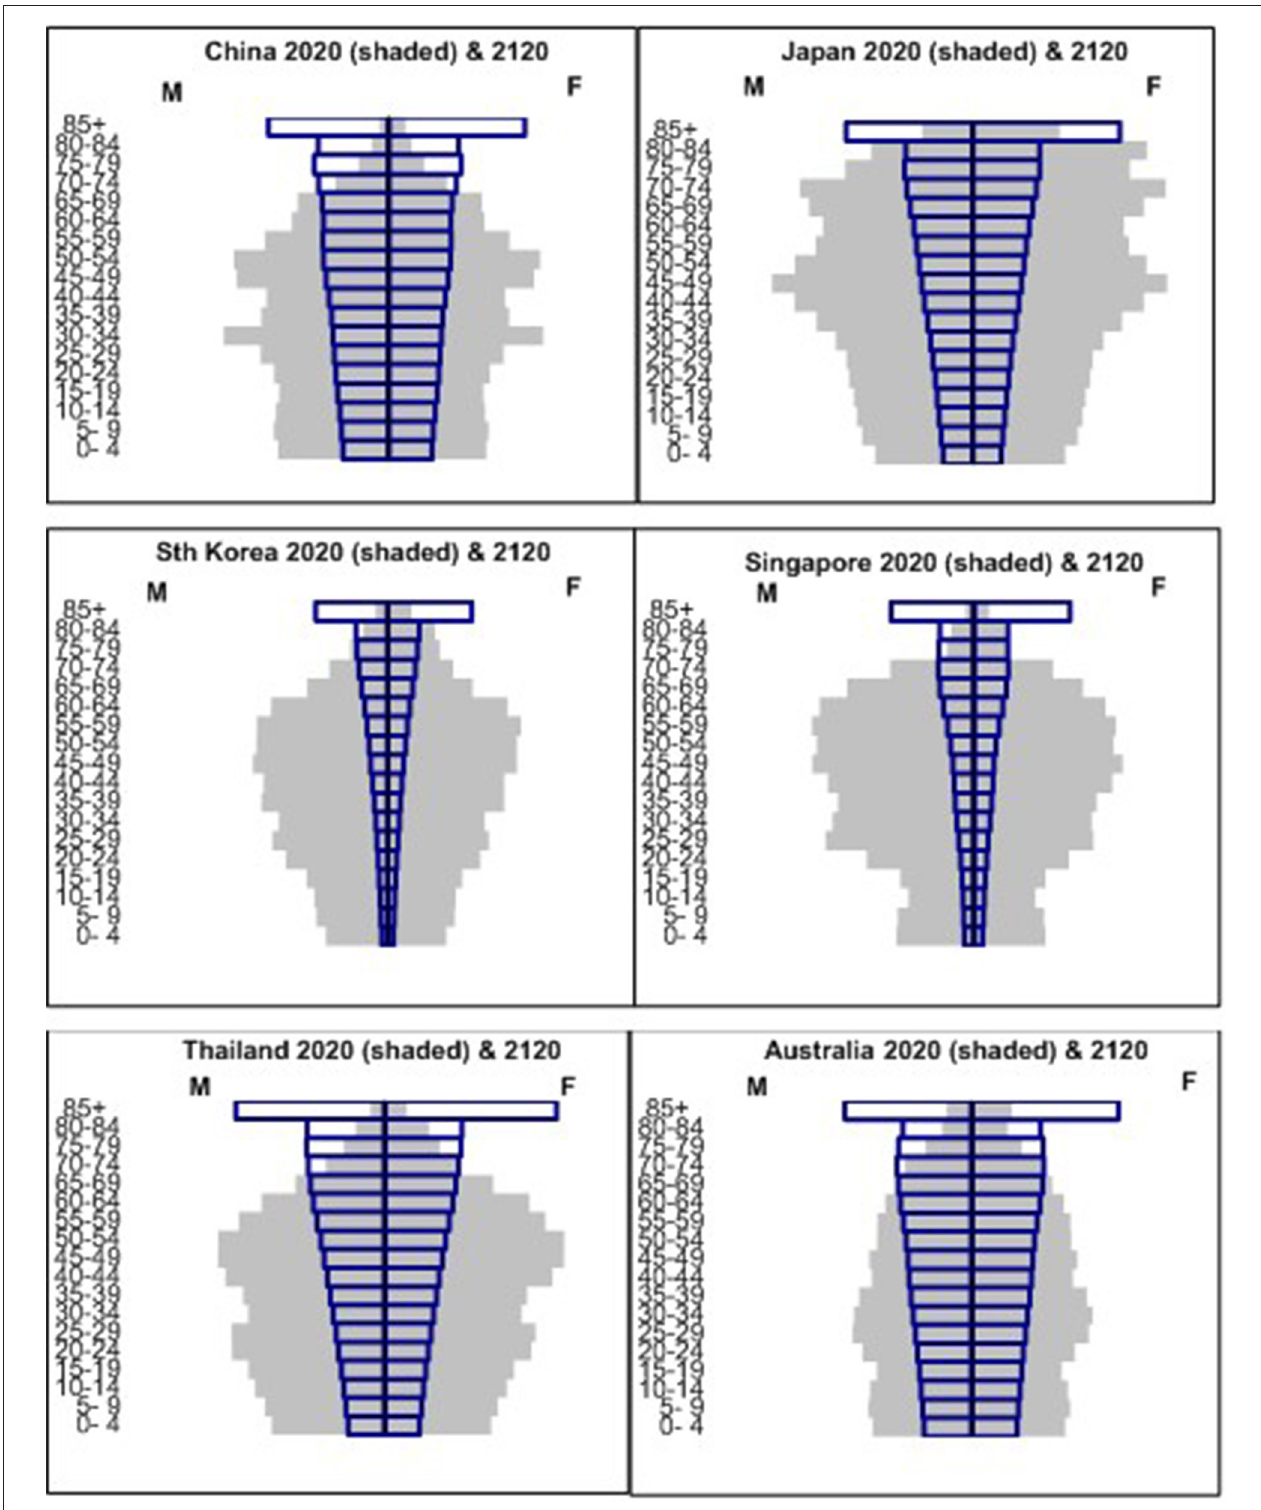
FIGURE 1 | Age distributions (numbers) in 2020 and 2120 assuming constant fertility and zero migration (Scenario A in subsequent graphs). Singapore refers to Singapore residents only.